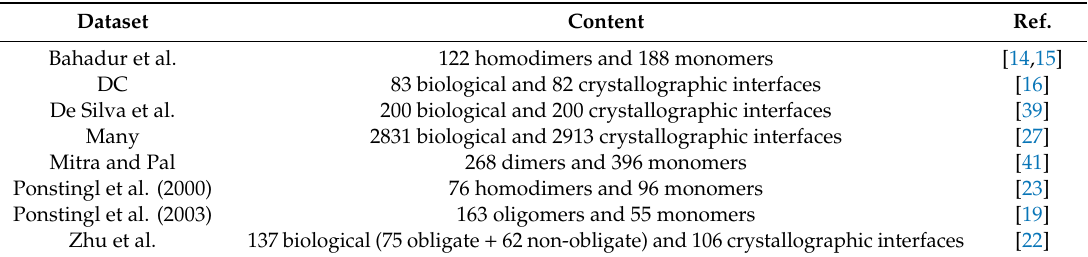
Table 2. List of biological interface